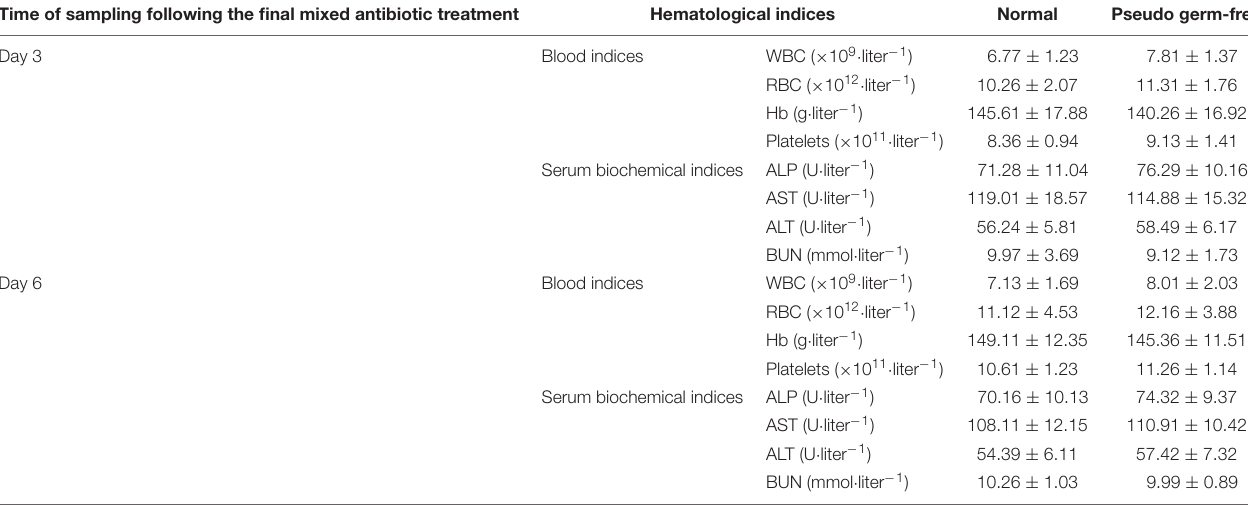
TABLE 2 | Hematological parameters of mice in normal group and pseudo germ-free group ( n = 5) + . Time of sampling following the final mixed antibiotic treatment